Question: Write a descriptive caption for this figure.
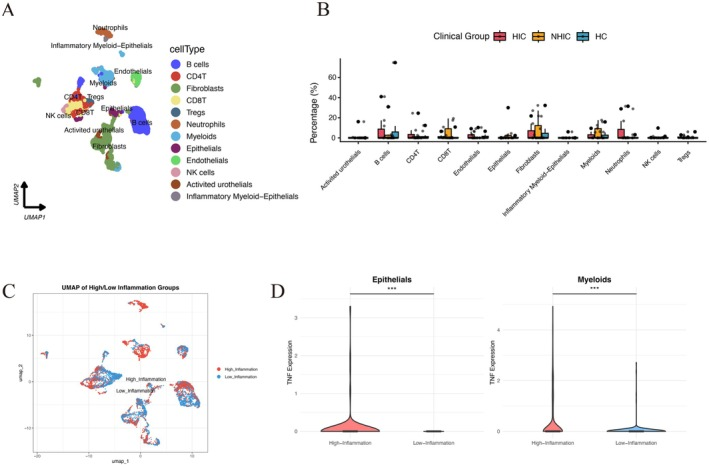
Answer: Single‐cell transcriptomic profiling of bladder tissues identifies distinct inflammatory cell states in IC/BPS. (A) UMAP visualization of bladder scRNA‐seq data, color‐annotated by 12 distinct cell types, including immune cells, stromal cells, and epithelial subsets. (B) Cell type composition analysis across three clinical groups: HIC (red), NHIC (yellow), and HC (blue), revealing differential immune cell infiltration between IC/BPS subtypes. (C) UMAP projection of all cells stratified into high‐inflammation subgroup (red) and low‐inflammation subgroup (blue) based on inflammatory gene expression signatures. (D) Violin plots showing significantly elevated TNF expression in epithelial and myeloid cells derived from the high‐inflammation subgroup.